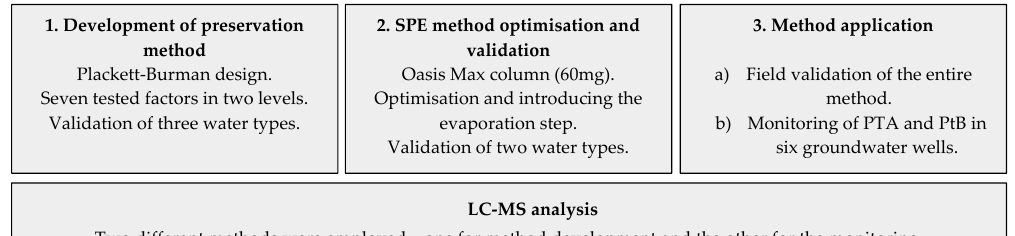
Figure 1. Experimental flow chart.